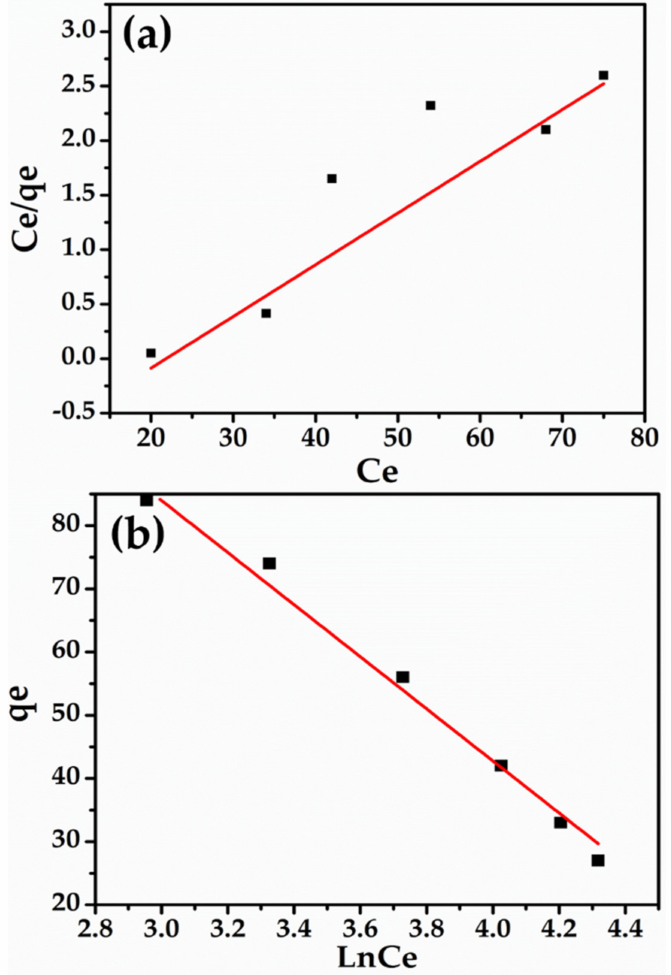
Figure 6. Adsorption isotherm ( a ) Langmuir isotherm and ( b ) Temkin